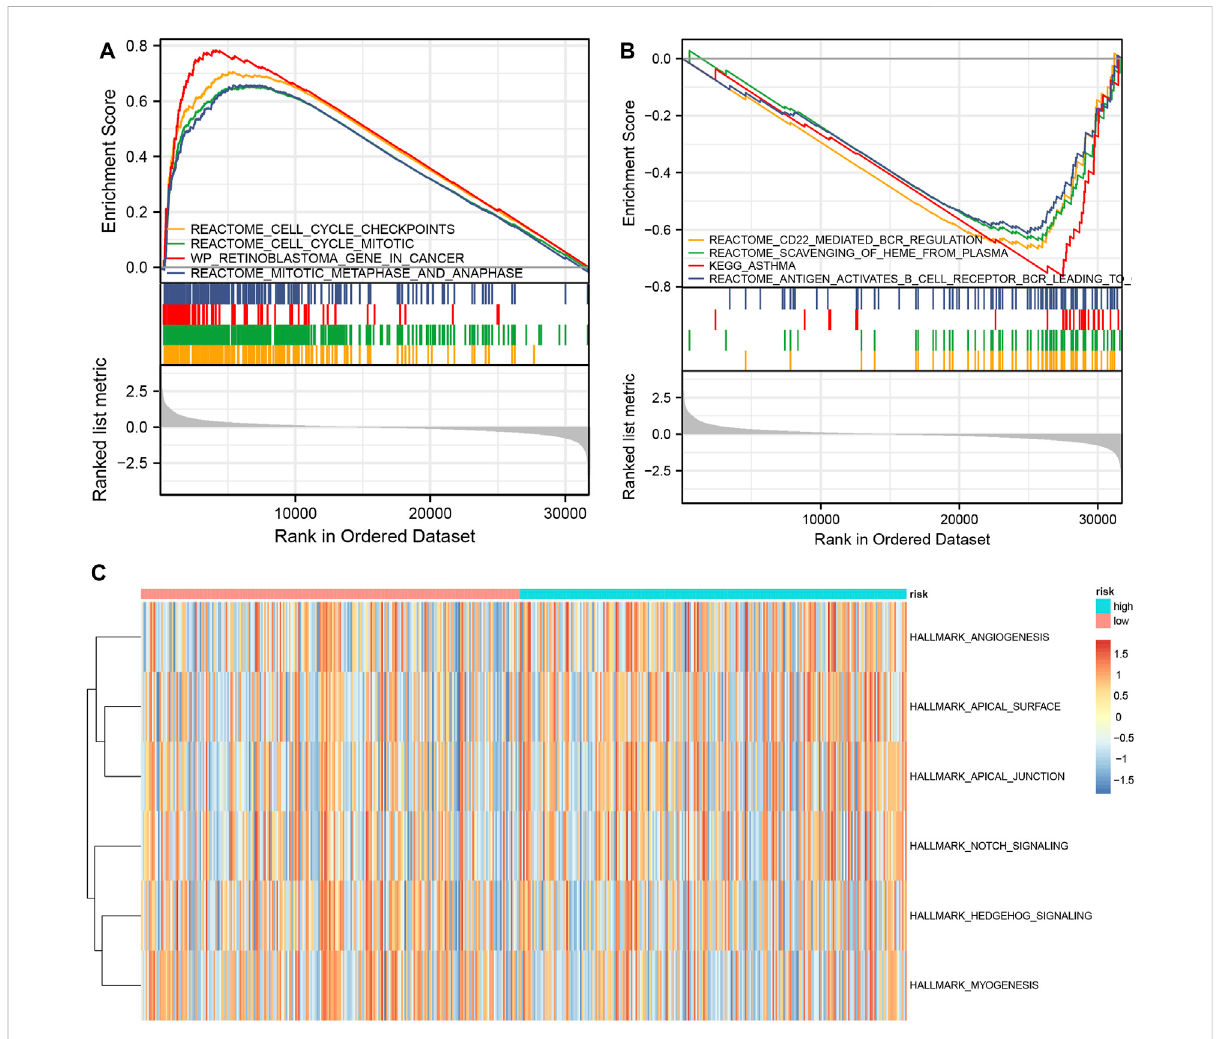
FIGURE 7 GSVAandGSEAanalysisofhigh-andlow-risk groups (A) Mainenrichedpathwaysinthehigh-riskgroup (B) Main enrichedpathwaysinthelow- risk group (C) Differential gene sets based on the hallmark gene